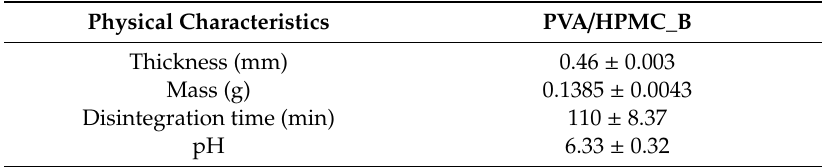
Table 2. Physical characteristics of the selected polyvinyl alcohol-hydroxypropyl methylcellulose (PVA / HPMC_B) film. Data are presented as the mean ± SE, n =